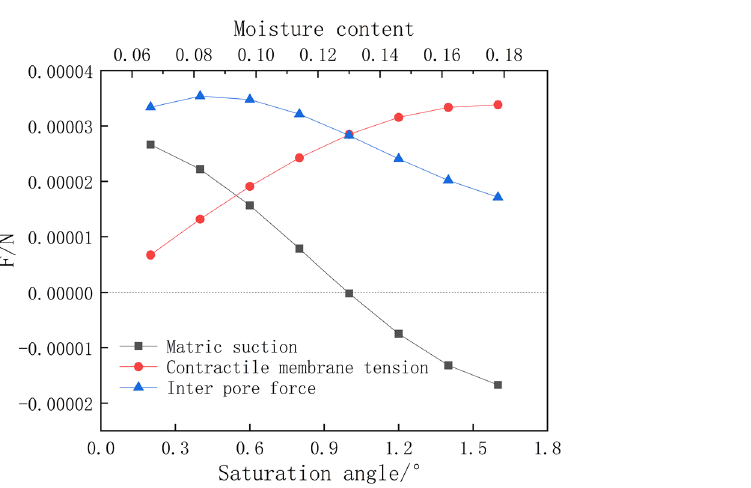
Figure 23. Capillary inter-pore forces versus water